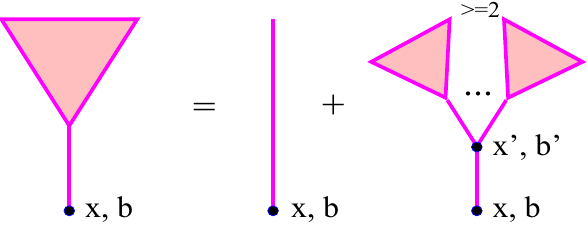
impact parameter space G I ( x , Q 2 , b ) , instead of the usual integrated parton distribution functions (PDFs), f I ( x , Q 2 ) = (cid:4) d 2 b G I ( x , Q 2 , b ) . Here s is the center of mass (c.m.)